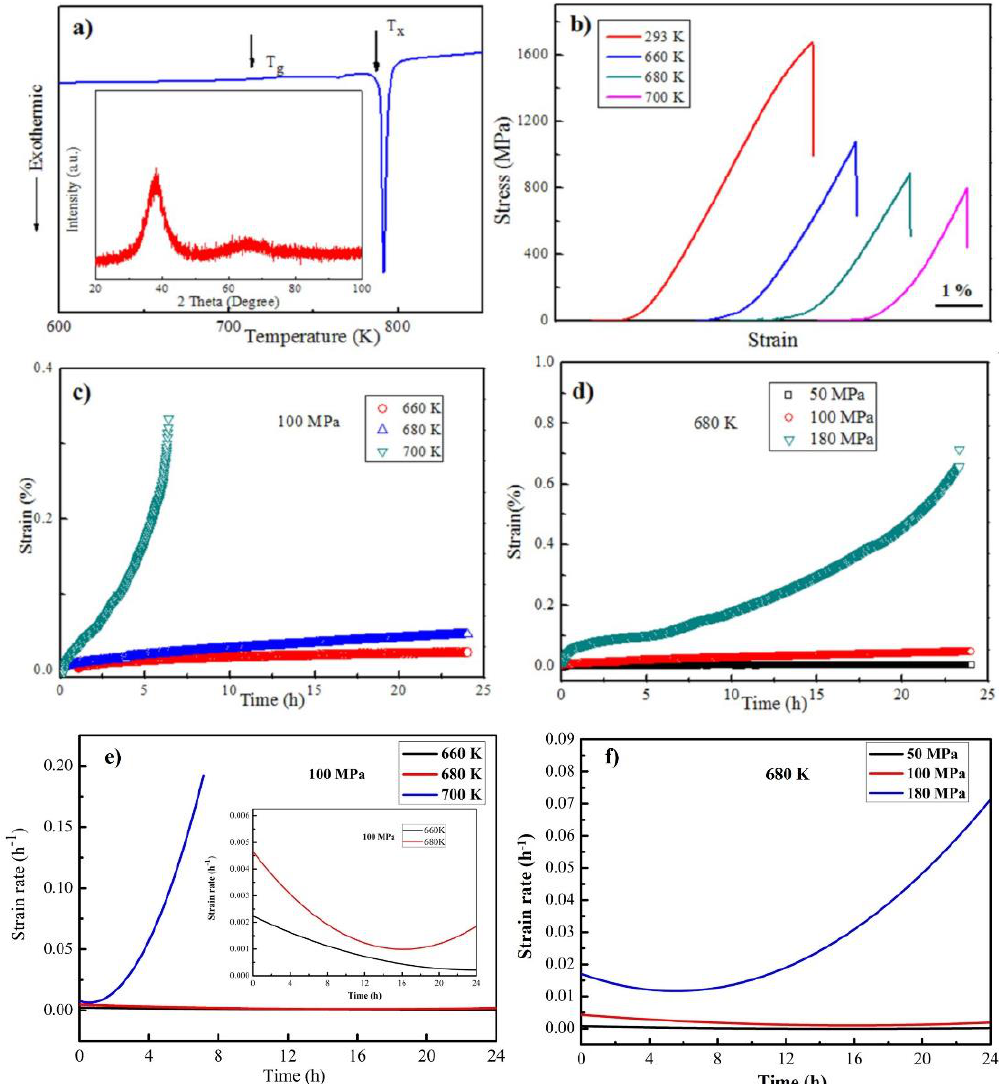
Figure 2. ( a ) Differential scanning calorimetry (DSC) curve, ( b ) tensile stress-strain curves at different temperatures, ( c , d ) tensile creep curves, and ( e , f ) the corresponding strain rate-time curves of the Zr-based BMG alloy with different creep parameters.